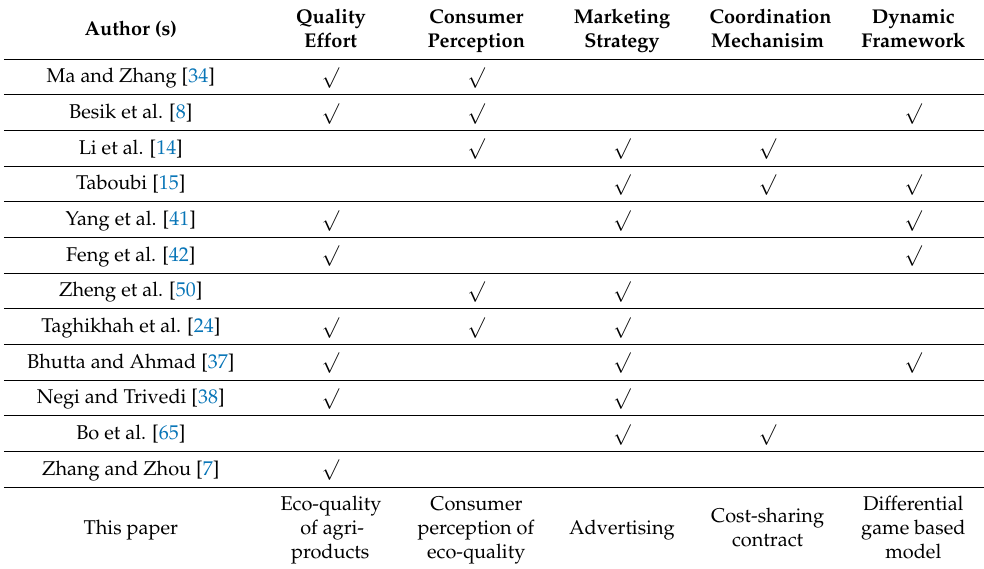
Table 1. Contribution of different authors.